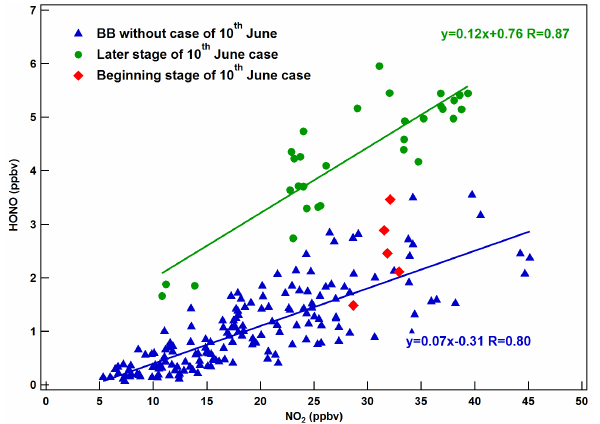
Figure 10. Scatter plot between HONO and NO 2 concentration dur- ing the BB periods (without the case of 10 June, blue solid squares), the beginning (red solid diamonds) and latter (green dots) state of the 10 June episode.